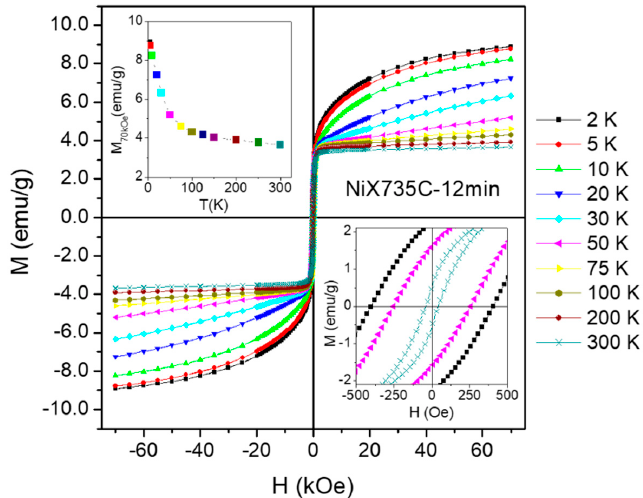
Figure 14. Room temperature saturation magnetization M s as a function of the total content of metallic Ni and hexagonal nickel hydride.